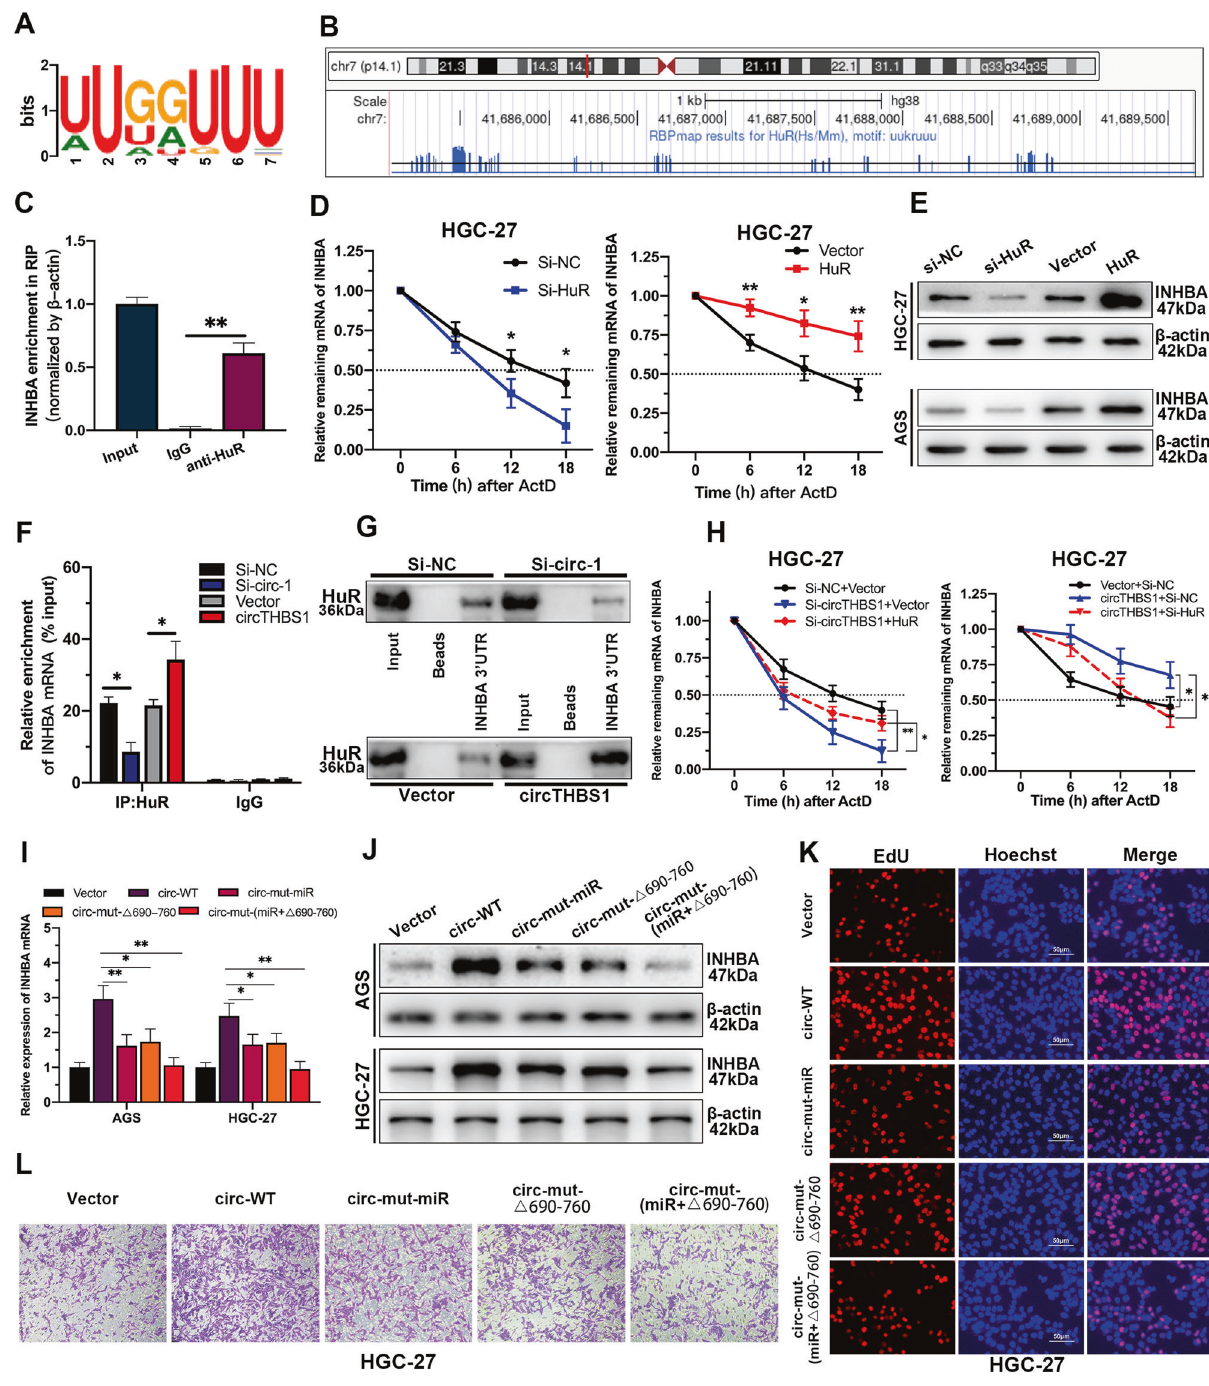
Fig. 6 CircTHBS1 stabilizes INHBA mRNA via interacting with HuR. A The motif of HuR. B The HuR binding sites in INHBA 3 ’ UTR region predicted by RBPmap. The bottom blue vertical lines represented the Hub binding sites in 3 ’ UTR of INHBA mRNA. C RIP assay shown that HuR protein interacted with INHBA mRNA. D Degradation rates of INHBA mRNA were detected by qRT-PCR in HuR overexpressing or knockdown HGC-27 cells at different time periods. E The expression of INHBA protein in GC cells transfected with si-NC, si-HuR, vector or HuR overexpression plasmids was detected by Western blot. F RIP assays showed the content of INHBA mRNA co-precipitated with HuR after knockdown or overexpression of circTHBS1 in HGC-27 cells. G RNA pulldown assays were performed in HGC-27 cells with biotin-labeled INHBA 3 ’ UTR. The HGC-27 cells were transfected with si-circTHBS1 or circTHBS1 overexpression plasmids. H Degradation rate of INHBA mRNA in HGC-27 cells transfected with different plasmids or small interferences. I, J The expression of INHBA in GC cells transfected with wild-type and mutant circTHBS1 overexpression plasmids. circ-mut-miR indicated the miR-204-5p binding site was mutant, circ-mut- Δ 690-760 referred to the sequence from 690 to 760 of circTHBS1 was truncated. circ-mut-(miR + Δ 690-760) referred to both mutated miRNA binding site and truncated part of the sequence. K, L EdU assays and Transwell of HGC-27 cells treated with wild-type or mutant circTHBS1 overexpression plasmids. Scale bar = 50 μ m. Quantitative data presented as the mean ± SD. * P < 0.05, ** P < 0.01, *** P < 0.001 (Student ’ s t -test).